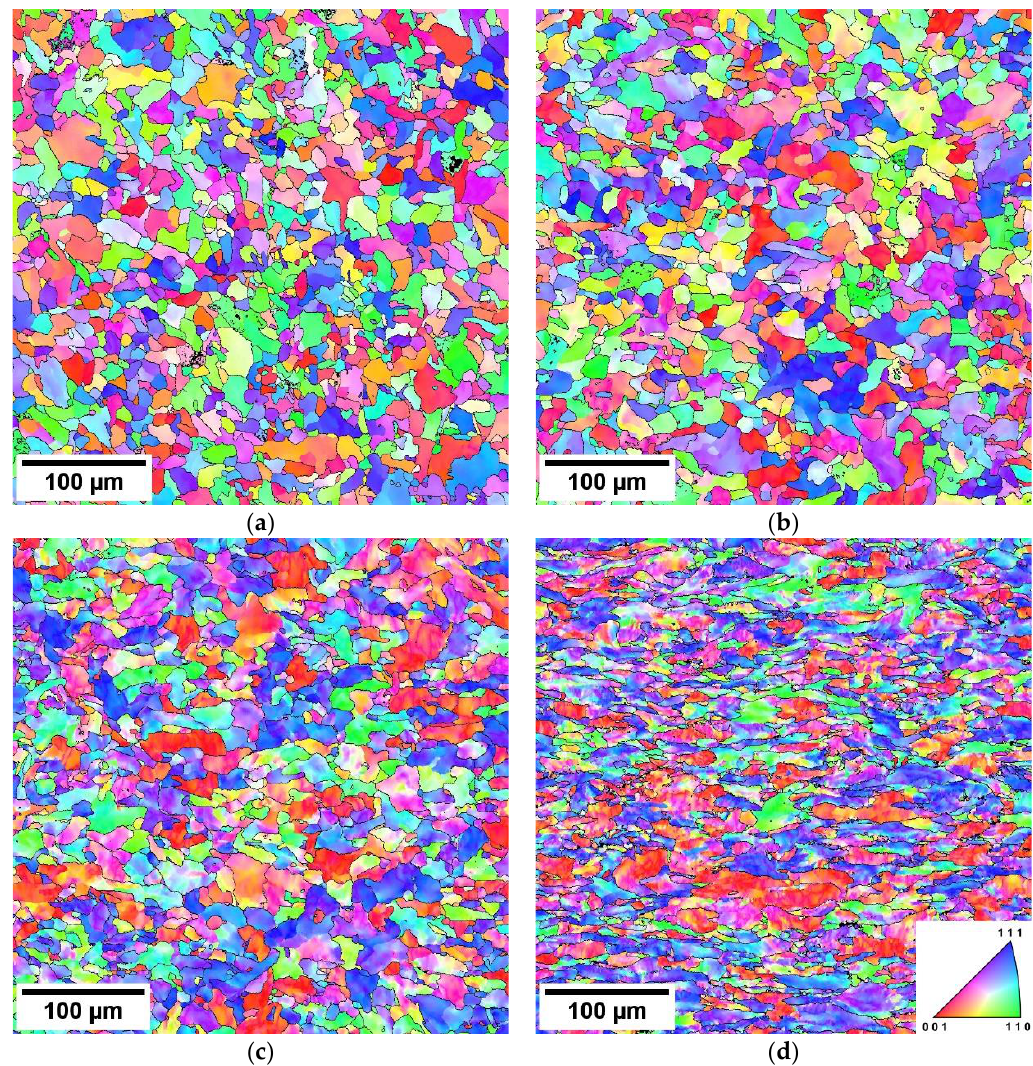
Figure 4. EBSD orientation maps. Tensile direction is horizontal. ( a ) ε = 2.5% ( b ) ε = 15%, ( c ) ε = 30 %, and ( d ) ε = 40% samples.